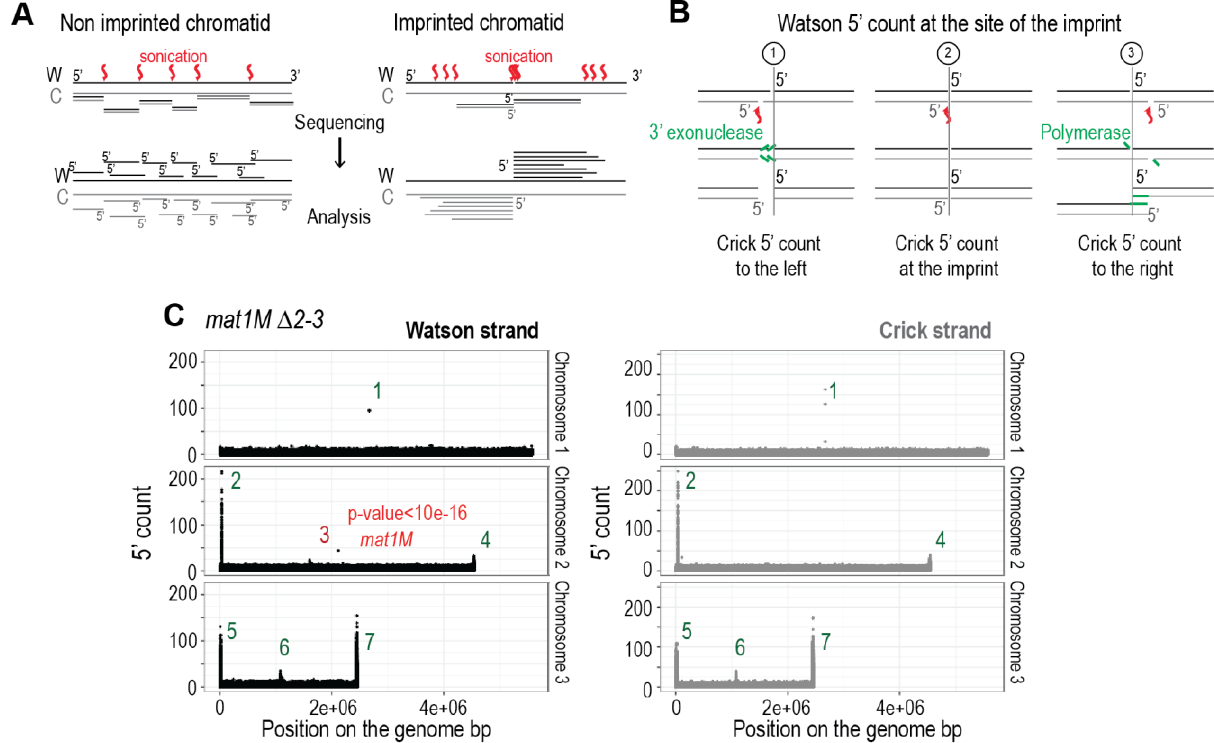
FIGURE 6: The imprint site is detectable by high throughput sequencing on the Watson strand. (A) Schematic view of the result of the sonication of both chromatid types. Red arrows indicate sites of sonication breakage. The black strand is the Watson strand (W) and the gray the Crick (C). 5' of Watson are shown in black and those of Crick in gray. Lower panel indicates the different types of reads obtained after sequencing. (B) Schematic representation of the blunting of the end that is used during libraries preparation. The Crick and Watson 5' ends are preserved after treatment. The Crick strand can break at 3 positions compared to the imprint site: to the left, across or to the right. (C) Distribution of the 5' count per position in the genome on both strands. mat1M ∆ 2-3 stain was used for the analysis. p-value is calculated using a theoretical t-student distribution that fits on the distribution of the whole-genome observed 5' count. Regions that have a high 5' count are